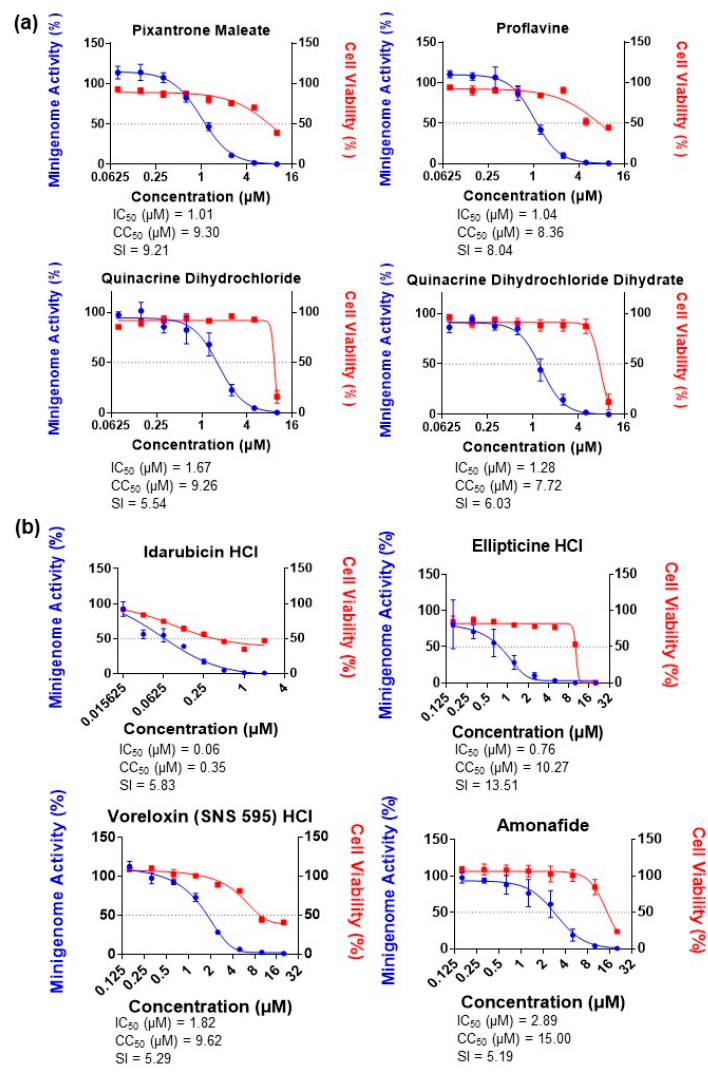
Figure 3. Inhibitory effects of identified candidates and topoisomerase II inhibitors against LASV MG. ( a ) Inhibitory effects of pixantrone maleate, proflavine, quinacrine dihydrochloride